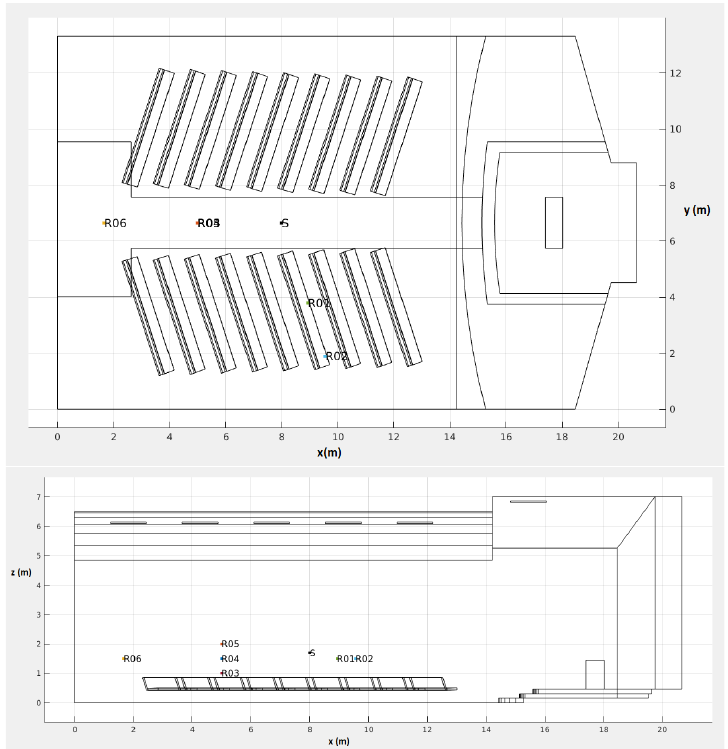
Figure 3. Layout of source (S) and six receivers (R01–R06), from x–y ( top ) and x–z ( bottom ) cross-sectional views. Note: R03–R05 are coincident in the top view, and axes units are in